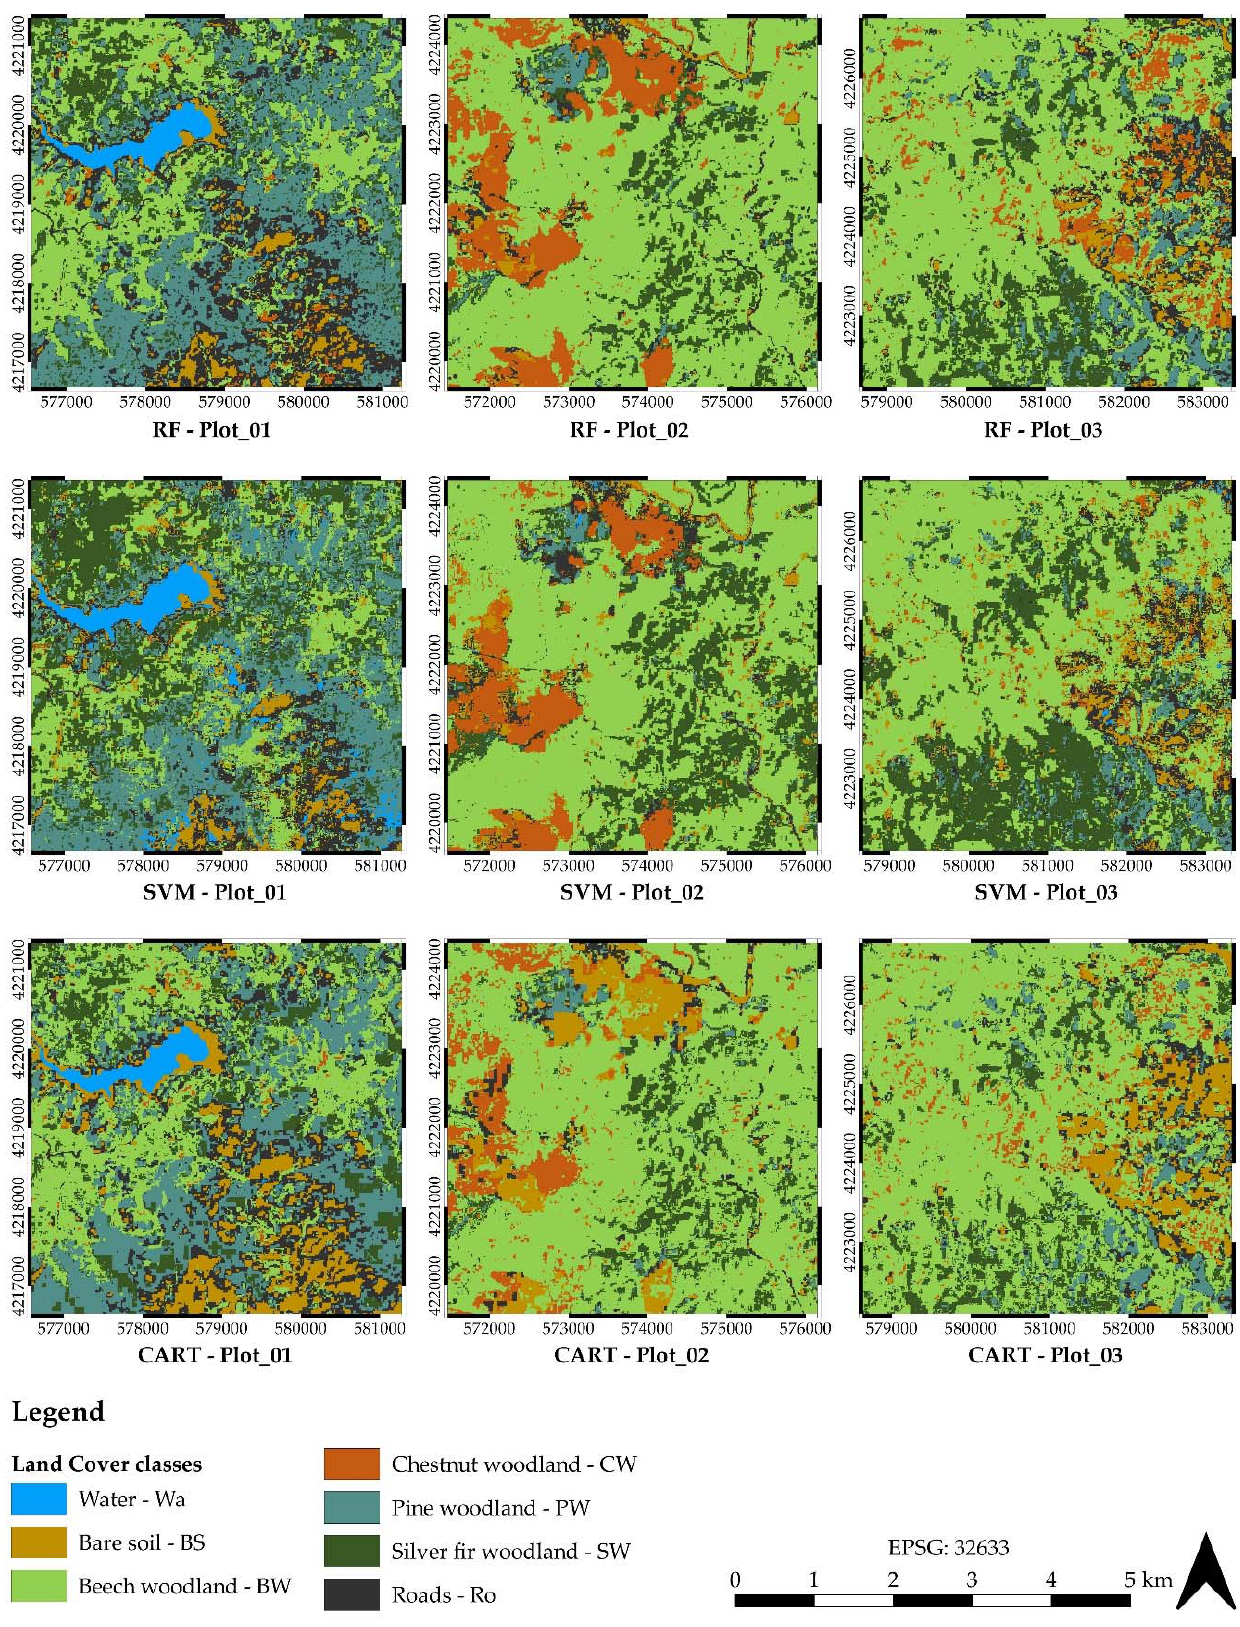
Figure 5. The maps resulting from each adopted classifier (RF: random forest; SVM: support vector machine; CART: classification and regression tree), in rows and, for each square plot, in columns.